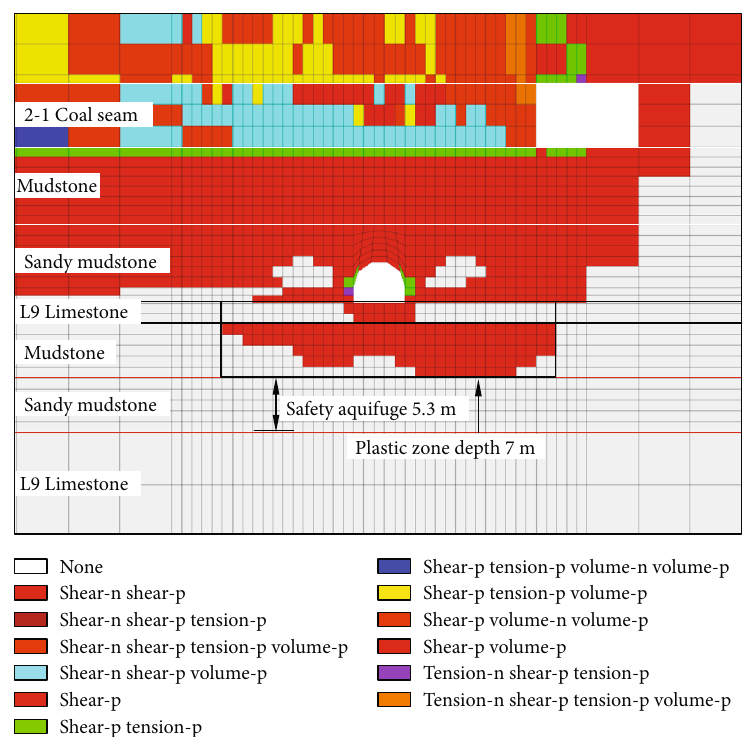
Figure 9: Failure of bottom rock stratum at y = 260 m in the fl oor drainage roadway at an internal stagger of